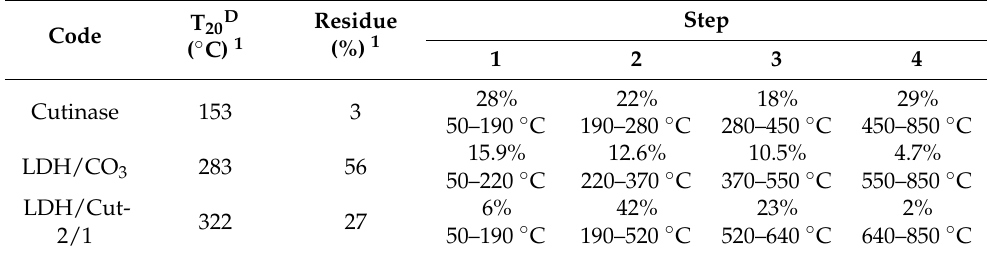
Table 3. Thermal stability, weight loss step, and corresponding temperature range of samples.